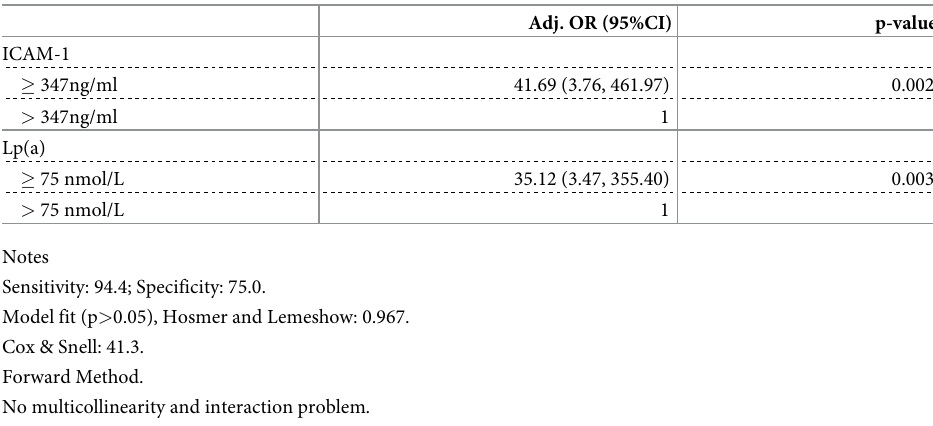
Table 6. Multivariate analysis in overall cohort.